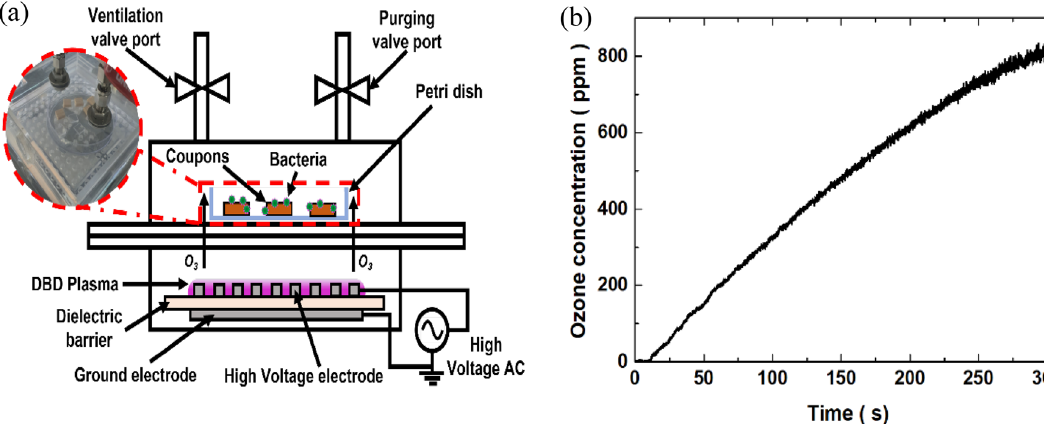
Figure 1. ( a ) Schematic of an experimental setup for sterilizing bacteria on various materials using ozone produced from a DBD plasma reactor, and ( b ) ozone concentration in the sterilization chamber with plasma generation time. The graph was plotted using the OriginPro version 9.0 (OriginPro software, Northampton, MA, USA; https:// www. origi nlab.